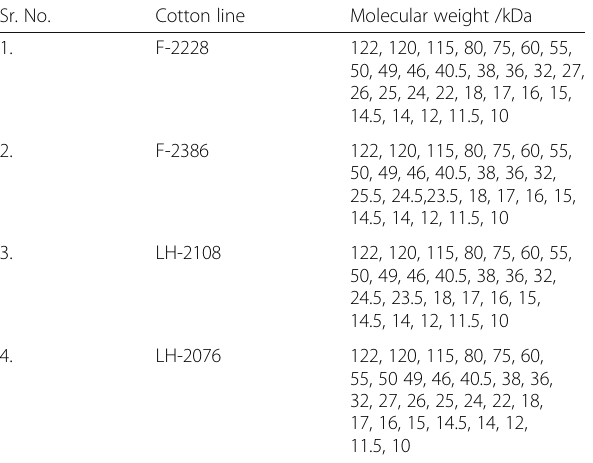
Table 4 Molecular weight of polypeptides in seed protein extracts of G. hirsutum under reducing conditions Sr. No.